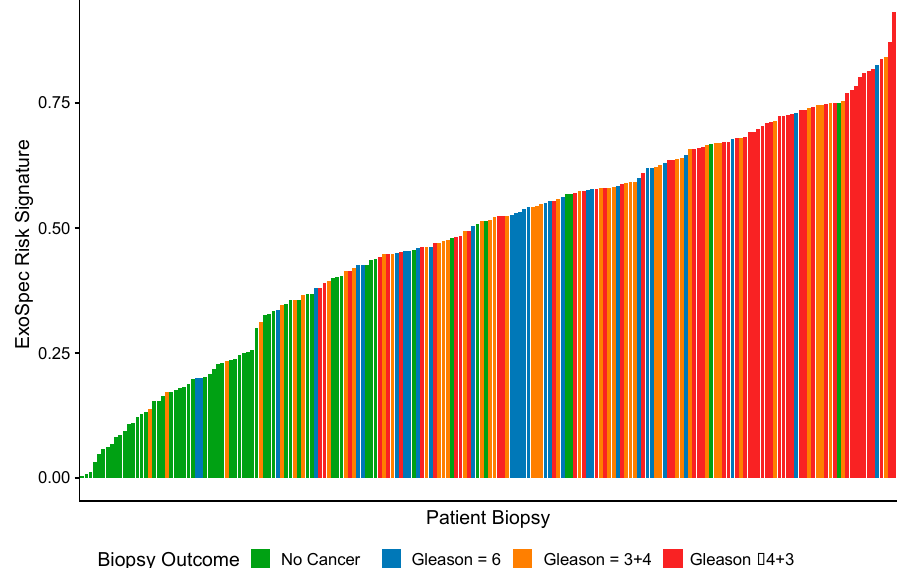
Figure 2. A waterfall plot showing how ExoSpec risk score varies with biopsy outcome (increasing